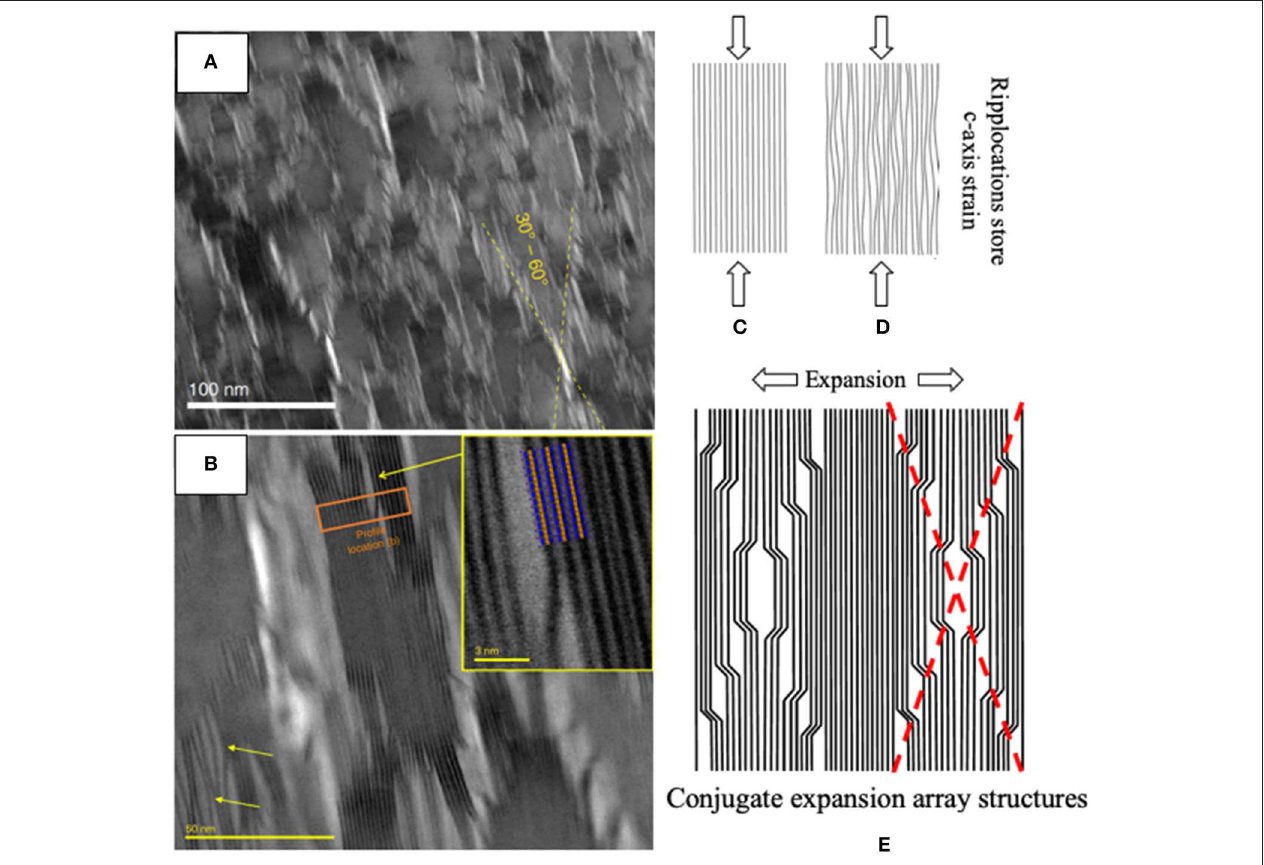
FIGURE 8 | (A) Transmission electron microscope micrographs of a natural biotite. Bright streaks are revealed to be up to 60 Å wide, lozenge-shaped lattice expansion, or delamination, structures of biotite basal planes. The acute angles of these diamonds measure between 30 ◦ and 60 ◦ . (B) Lattice curvature and interlayer expansion. Inset is a higher magnification image of the orange rectangle shown in micrograph emphasizing atomic nature of the deformation. (C) Perfect layers subjected to compression. (D) Ripplocations store c-axis strain that, when released, results in, (E) Conjugate arrays of expansion structures and